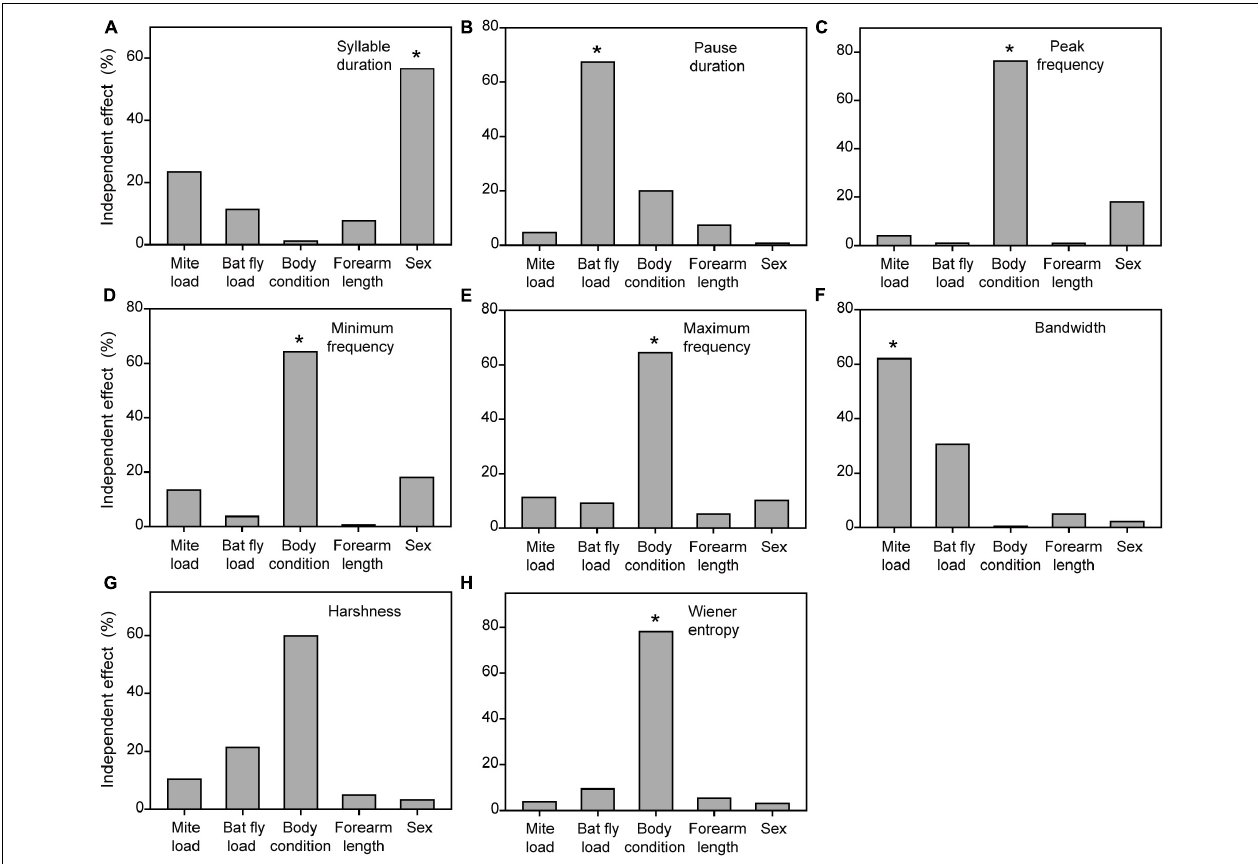
FIGURE 2 | Independent contributions (%) of the five explanatory variables to the inter-individual variation in syllable duration (A) , pause duration (B) , peak frequency (C) , minimum frequency (D) , maximum frequency (E) , bandwidth (F) , harshness (G) , and wiener entropy (H) of distress calls, calculated with hierarchical partitioning. Asterisks denote statistical significance (* P <